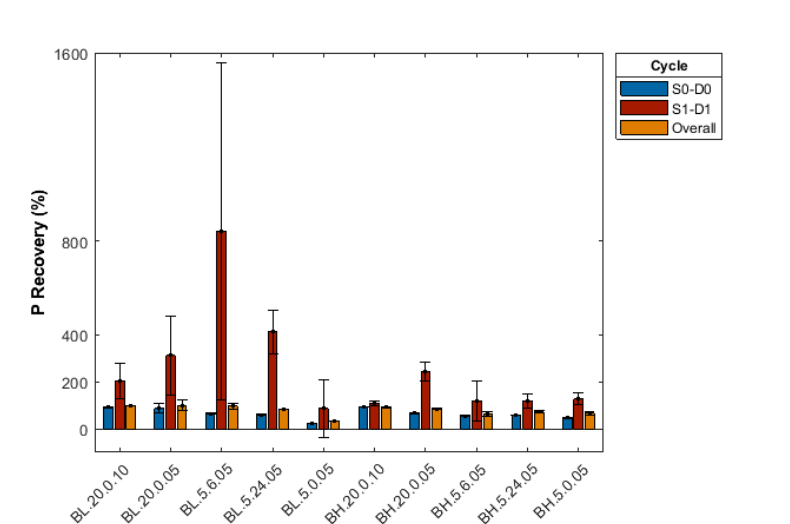
Figure 9. Phosphorus (P) recovery across all evaluated cycles and treatments for Biomax. The treatments identified on the x-axis follow the notation: PX.PV.RC.RT, with X being the level of P concentration (L for low or 0.5 mg L − 1 and H for high or 50 mg L − 1 ), PV: pore volume (5 or 20), RC: number of recirculations (0, 6, or 24) and RT: residence time used in the desorption